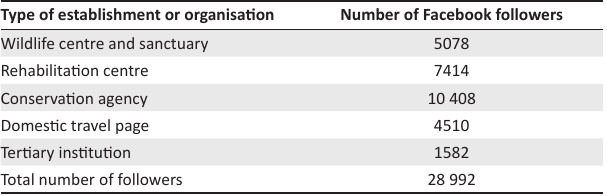
TABLE 1: Breakdown of participating